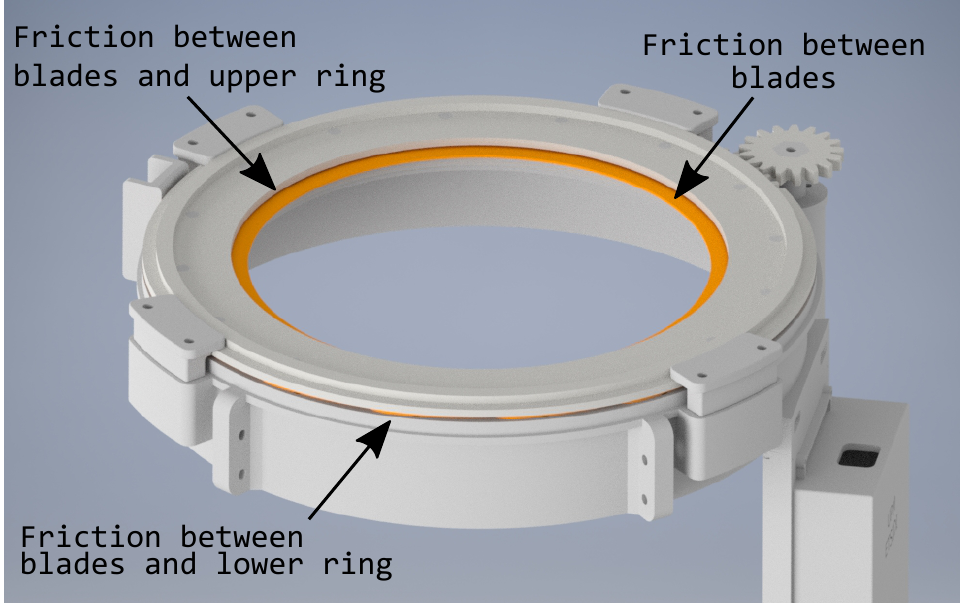
Figure 7. Friction